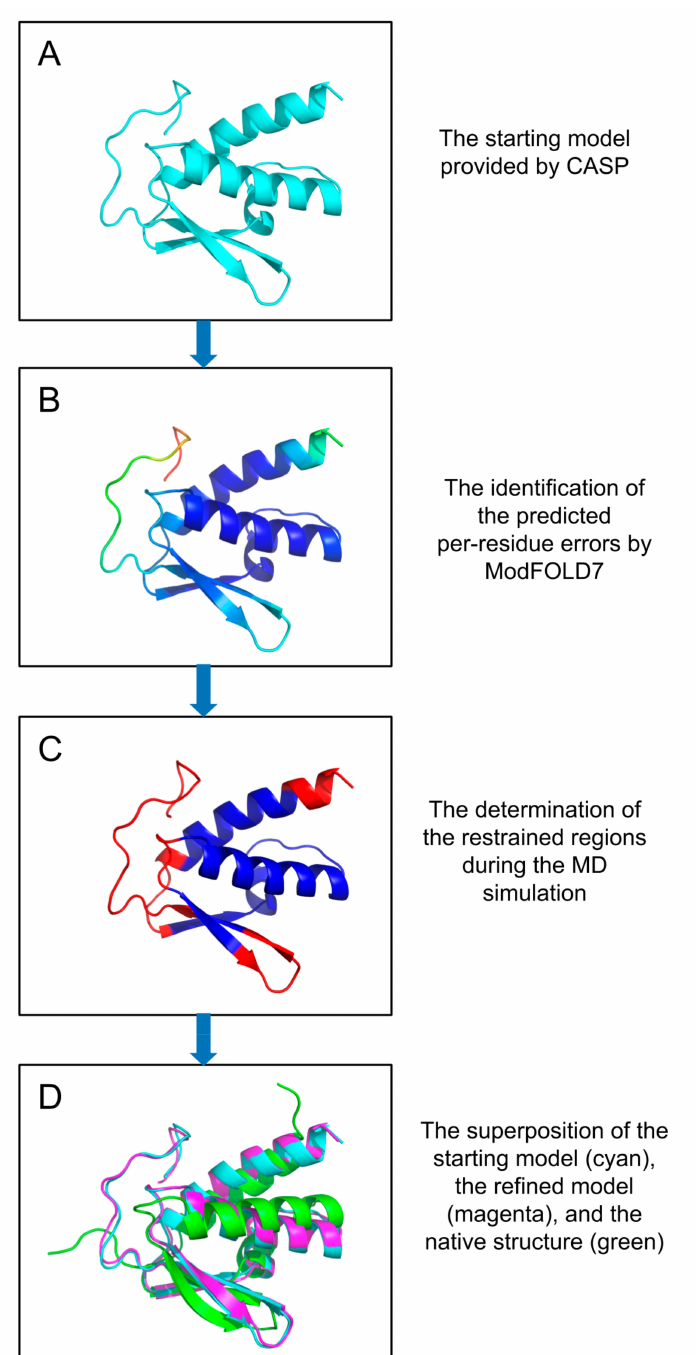
Figure 2. Example of refinement of a CASP13 model by the McGu ffi n group. The predicted per-residue error is produced by ModFOLD7 and, then, a new restraint strategy, based on the predicted per-residue error, is applied during the sampling stage: ( A ) CASP13 prediction target T0958; ( B ) top selected server model (BAKER-ROSETTASERVER_TS2), displayed using the B-factor scheme; ( C ) the top selected server model is coloured using an occupancy column, where blue regions indicate restrained residues and red regions indicate unrestrained residues during the MD simulation; ( D ) superposition of the top selected server model (cyan), refined model (magenta), and native structure (green). T0958: BAKER-ROSETTASERVER_TS2 versus T0958_ReFOLD_8, a GDT_HA improvement from 0.419 to